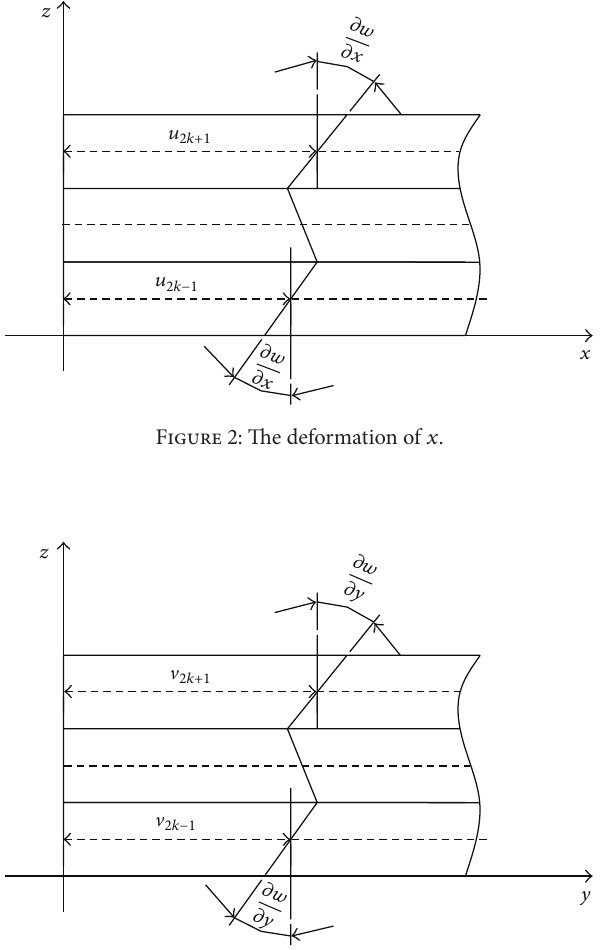
Figure 3: The deformation of 𝑦